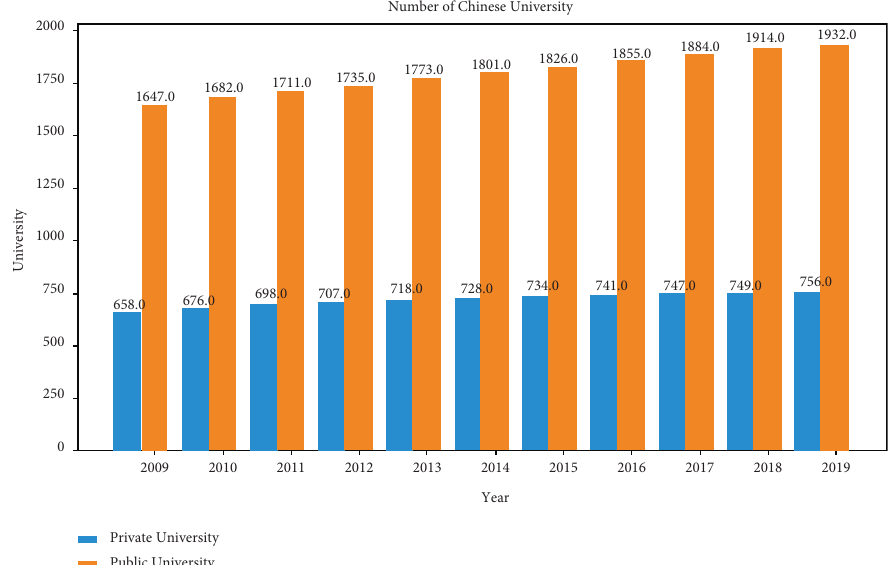
Figure 1: The number of Chinese public universities and private universities. Note: the data are from the website of the Chinese National Statistical Bureau: http://www.stats.gov.cn/.